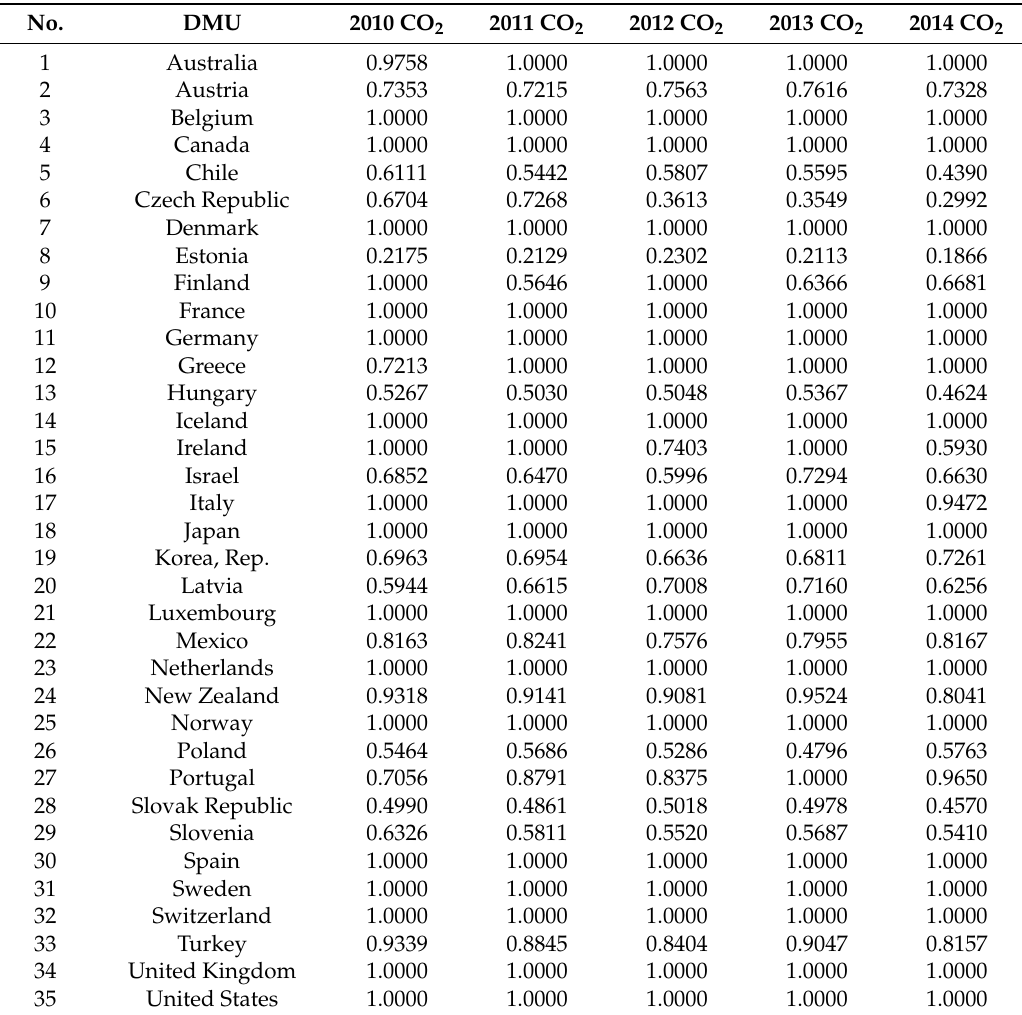
Table 7. CO 2 emissions efficiency from